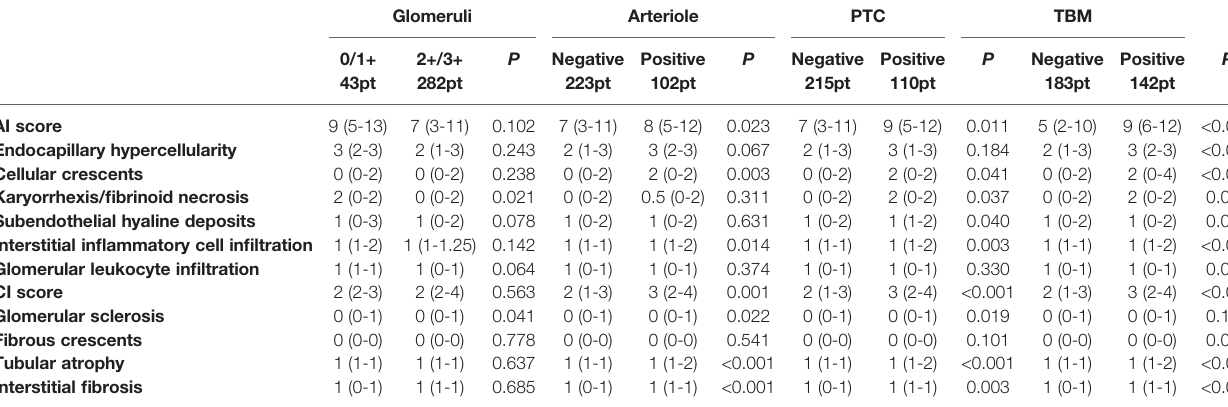
TABLE 4 | Comparison of renal histopathological data in patients with and without C4d deposition in different renal compartments.